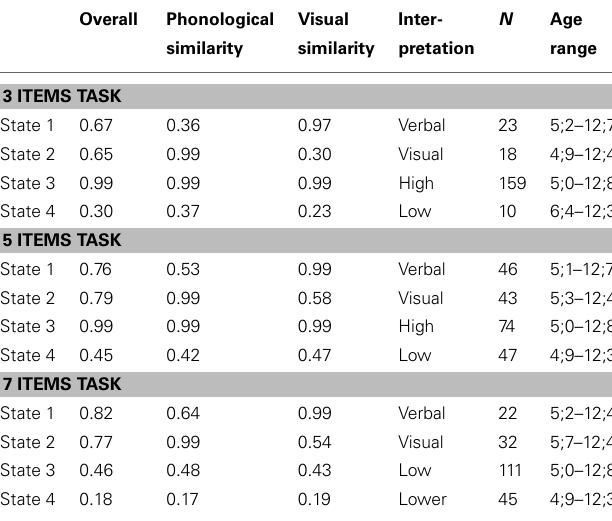
Table 2 | Probabilities of a correct score, interpretations, and characteristics of each latent